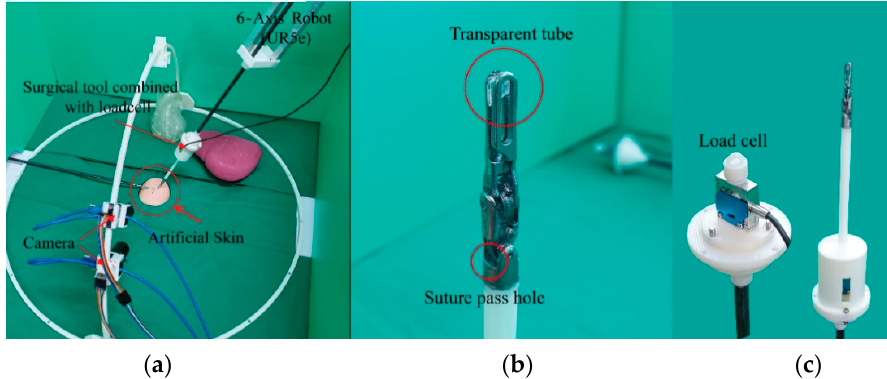
Figure 2. ( a ): Experimental setup. ( b ): Tool tip for measuring tensile force. ( c ): Instrument combined with load